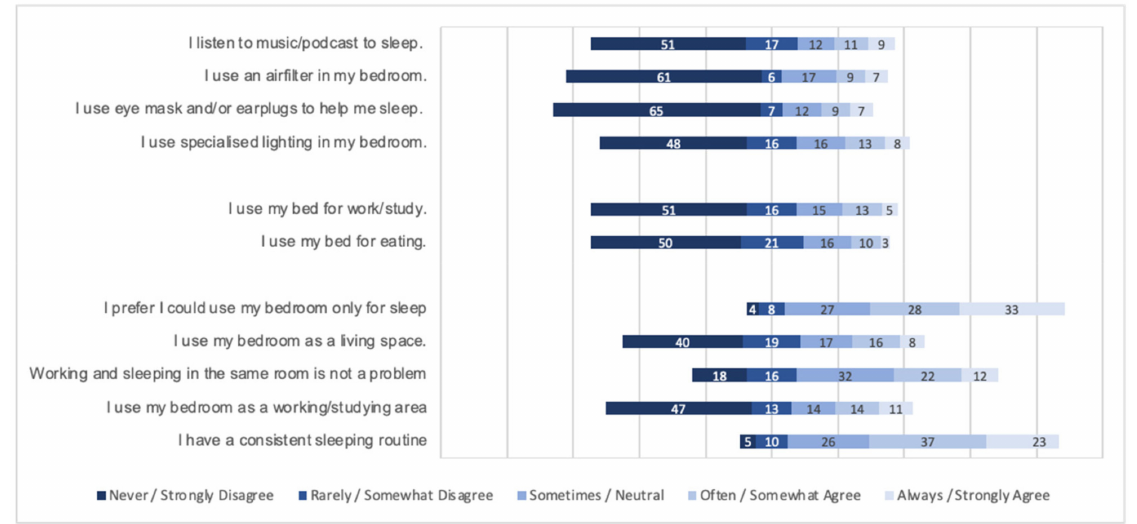
Figure 4. Analysis of the Likert-scale questions based on bedroom